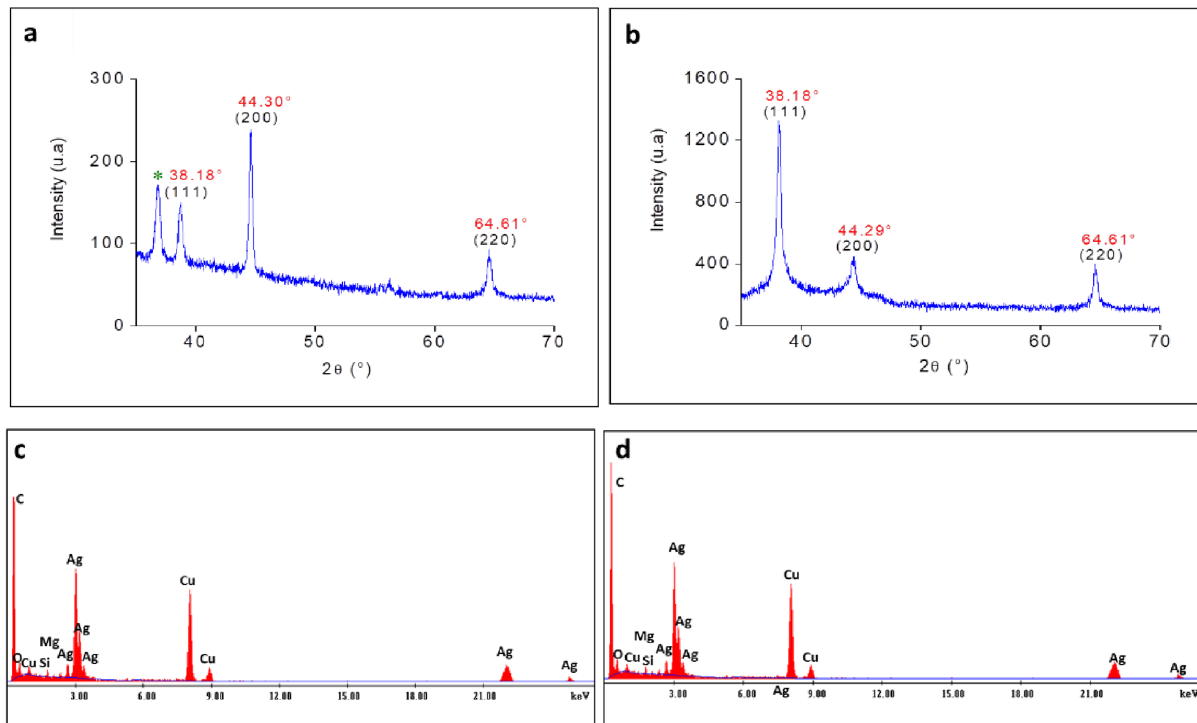
Figure 3. Characterization of AgNPs. X-ray diffraction of AgNPs formed in (a) control culture supernatant and in supernatant of culture grown in presence of (b) 250 mT SMF. Elemental composition of AgNPs formed in (c) control culture supernatant and in supernatant of culture grown in presence of (d) 250 mT face-centered cubic lattice structure of metallic silver (JCPDS-ICDD files No 04-0783). This confirms the suc- cessful synthesis of AgNPs and establishes their crystalline nature 27,28 . Similar diffraction patterns were observed with AgNPs biosynthesized using other yeast and plant extracts 29–32 . These data confirmed the purity of the synthesized nanoparticles. Elemental composition on the surface of the biosynthesized nanoparticles was determined using EDX spec- troscopy. In general, the optical absorption peak of silver appears at around 3 keV due to SPR 33,34 . As shown in Fig. 3c,d, EDX analysis revealed the presence of silver in the nanoparticles formed from SMF-treated cultures and those of controls. Silver peaks were the most prominent for all the samples, but no nitrogen peaks were evident in the EDX patterns of the AgNPs formulations. This indicates that no ions from AgNO 3 were present in AgNPs, consistent with complete reduction of silver ions as indicated by UV–Vis spectroscopy and visual observation. In addition to silver peaks, EDX revealed the presence of carbon and copper atoms on the surface of the biosynthe- sized AgNPs that may be due to the TEM grid composition. We also noticed that these silver nanoparticles were accompanied by different trace impurities magnesium (Mg) and silicon (Si). It is known that organisms such as yeasts, fungi, and plant metabolites have previously been reported to act not only as reducing agents but also as capping agents for AgNPs 35,36 . Herein, it could be hypothesized that the extracellular synthesis of AgNPs occurs due to the adsorption of silver ions on the surface of metabolic products (enzymes, polysaccharides, compound derived magnesium or silicon, etc.) present in the culture supernatant of S. cerevisiae , which reduce the Ag + to AgNPs. While, the effects of SMF on the synthesis of nanoparticles have not yet been elucidated, it is believed that SMF creates wave cavitation through the liquid that may enhance the decomposition of biomolecules and liberate free radicals, which then act as reducing agents. Antibiotic resistance of human pathogens is an important public health concern. Nanoparticles may pro- vide a viable alternative to conventional antibiotics 37 . The biosynthesized AgNPs, in our study, showed effective inhibition of bacterial growth (Table 1 and Fig. 4). Their respective minimum inhibitory concentration (MIC) and minimum bactericidal concentration (MBC) were 25 µg/mL and 70 µg/mL for AgNPs SMF ; 40 µg/mL and 90 µg/mL for AgNPs CONTROL for E. coli . While, S. aureus showed the respective value of MIC and MBC: 15 µg/ mL and 50 µg/mL for AgNPs SMF ; 20 µg/mL and 70 µg/mL for AgNPs CONTROL These results suggest that the AgNPs prepared from cultures grown in SMF displayed good to excellent inhibitory effects as antibacterial agents, due to their smaller size. Generally, the difference in the peptidoglycan layer of the bacterial cell between Gram ( +) and Gram (–) bacteria plays a crucial role in the inhibitory activity 38–40 . In addition, the negative surface charge